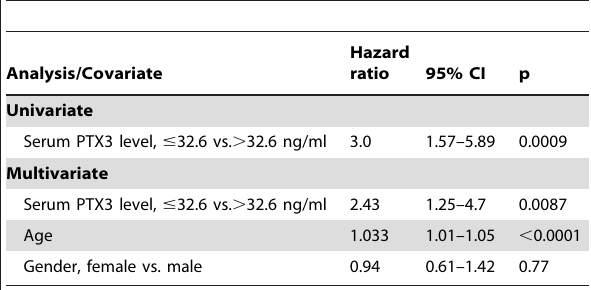
Table 3. Cox regression analyses of association between serum concentrations of PTX3 below and above the 25th percentile at time of admission and 90-day